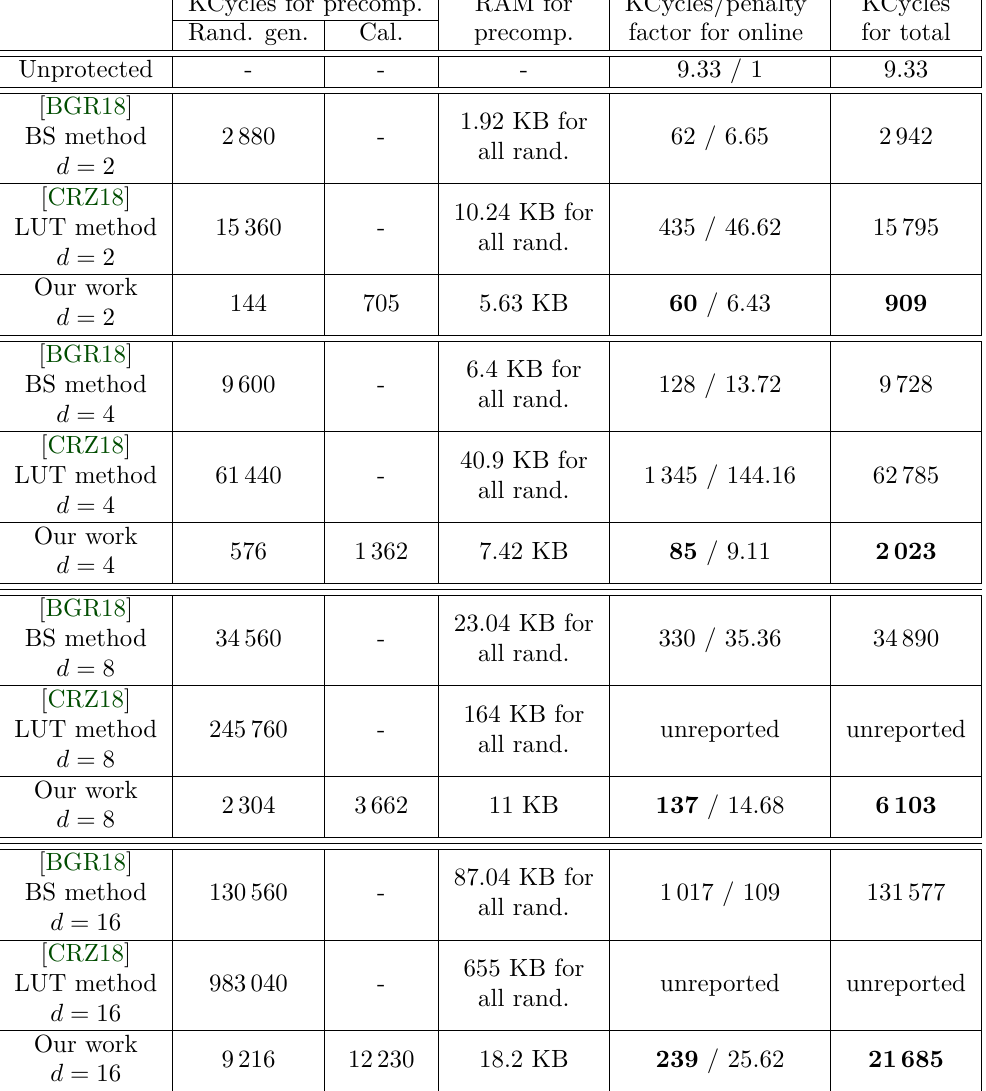
Table 2: Summary of masked AES implementations in the precomputation-based design paradigm (in kilos of clock cycles for timings). KCycles for precomp. RAM for KCycles/penalty KCycles precomp. factor for online for totalRand. gen. Cal. Unprotected 9 .